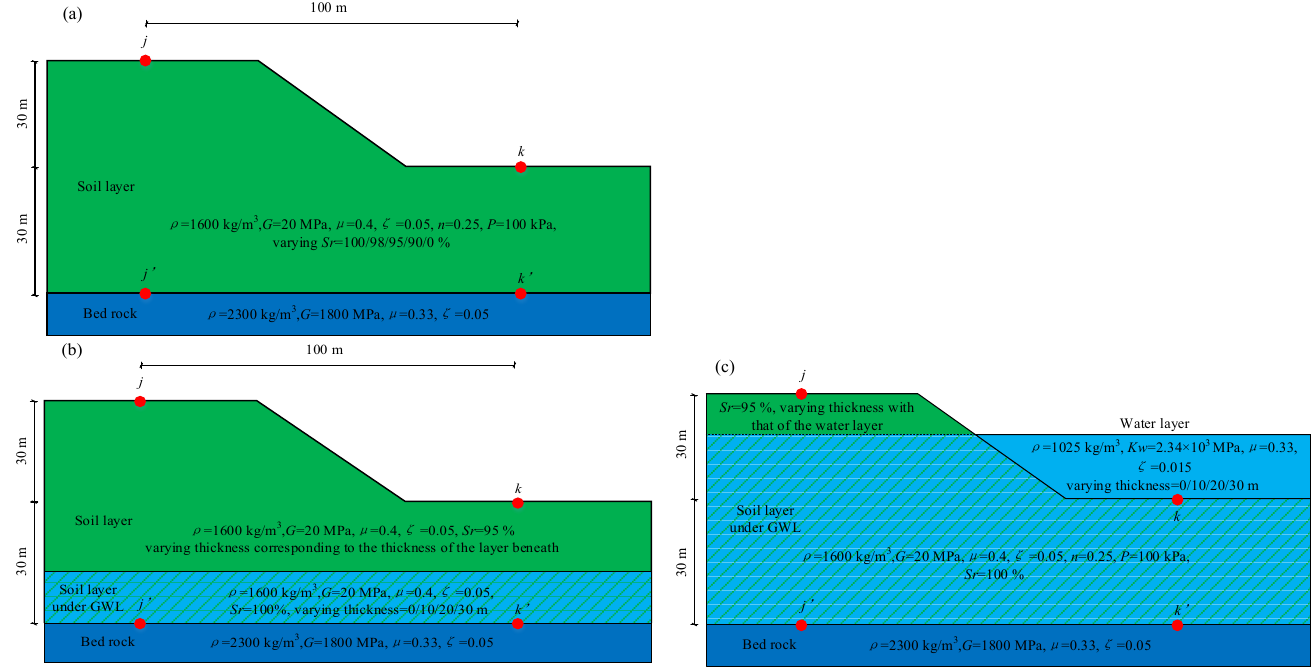
Figure 1. Diagrams of site conditions for: ( a ) the case with varying SD; ( b ) the case with varying GWL; ( c ) the case with varying WLT at point k (not to scale). Table 1. Study cases performed.